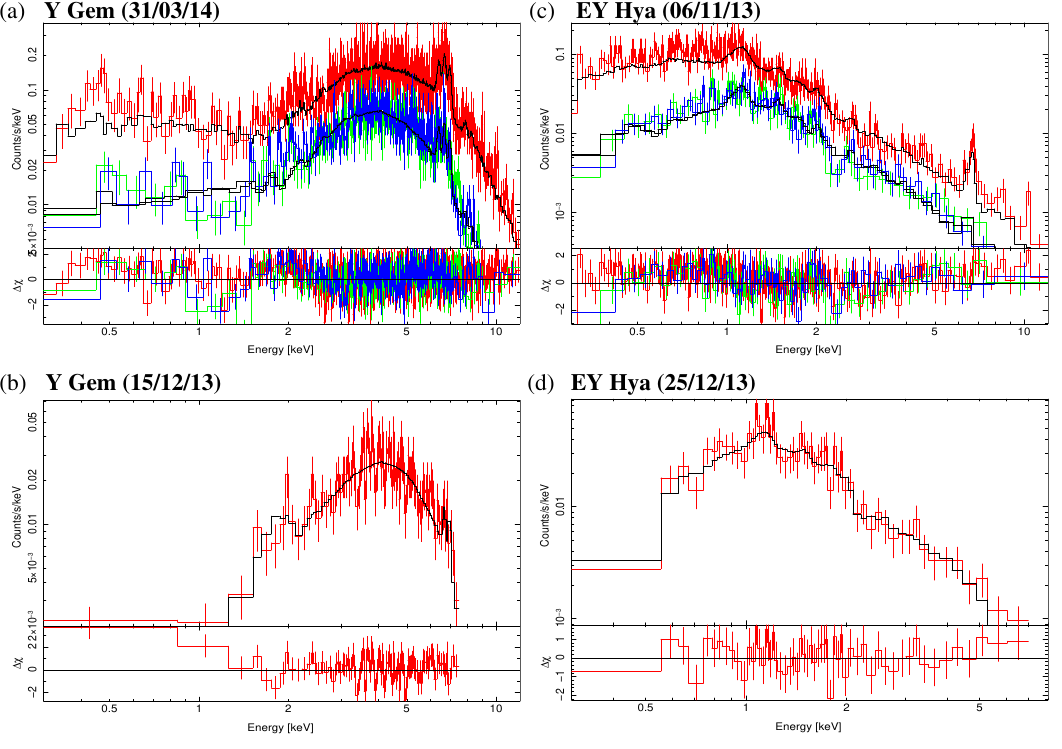
Figure 3. X-ray spectra ( colored curves ) for the fuvAGB stars YGem and EYHya, taken at/with different epochs/observatories+instruments, together with APEC model fits ( black curves ): ( a ) Y Gem (31/03/14: XMM-Newton), ( b ) Y Gem (15/12/13: CXO), ( c ) EY Hya (06/11/13: XMM-Newton), and ( d ) EY Hya (25/12/13: CXO). XMM (EPIC = pn + MOS1 + MOS2) data are shown as follows – pn:red, MOS1:green, MOS2:blue. CXO (ACIS-S) data are shown as red curves. The model X-ray luminosity (Lx), temperature (Tx), and absorbing column density (NH) are, (i) for Y Gem: Lx = 0.226 (0.115) L (cid:12) , Tx = 10 8.1 (10 8.2 )K, and NH = 8.13 (15.6) × 10 22 cm − 2 for epoch 31/03/14 (15/12/13), and (i) for EYHya: Lx = 0.0024 (0.002) L (cid:12) , Tx = 10 7.74 (10 7.57 )K, and NH = 0.05 (0.095) × 10 22 cm − 2 for epoch 25/12/13 (06/11/13) (adapted from Sahai et al. (2015) [17])